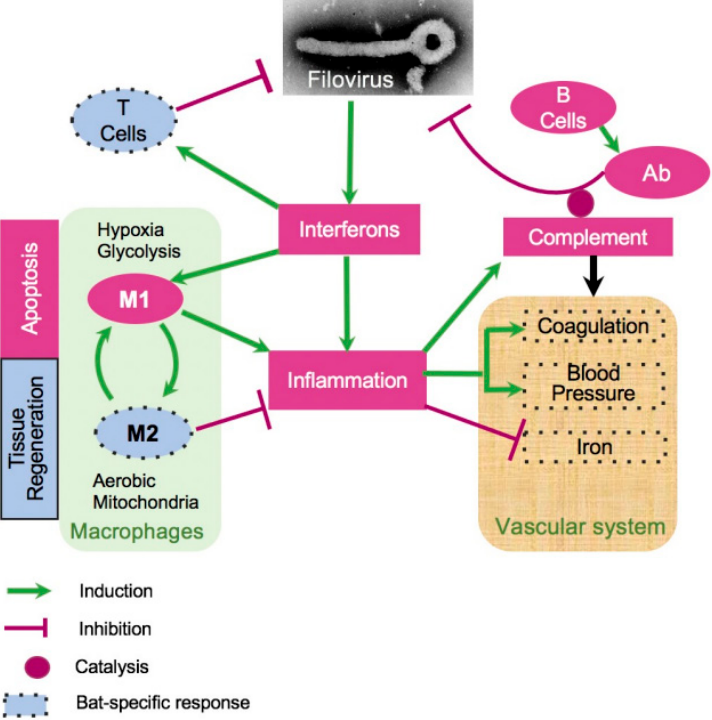
Figure 5. A model of bat response to filovirus infections. Interferon stimulated genes (ISG, Figures 4, S2 and S3) cause inflammation, which triggers the acute phase response (APR, Table 1, Figure 4), leading to a cascade of reactions affecting regulation of HAMP (iron, Figures 4 and S6), coagulation (Figures 4, S7 and S8), blood pressure (Figures 4 and S7), and stimulating M1 macrophages (Figures 4, S5, S10 and S11). The pro-inflammatory M1 macrophages phagocytose infected cells and promote apoptosis. Over the course of infection, M1 macrophages are converted to anti-inflammatory M2 macrophages. This process is accompanied by activation of fatty acid oxidation and mitochondrial activity, which are the hallmarks of the M2 macrophage responses (Figures 4, S10 and S11). On the other hand, activation of the complement system is incomplete, potentially leading to a reduced antibody activity (Figures 4 and S5B). Furthermore, filovirus infections were accompanied by down- regulation of blood pressure (Figures 4 and S7) and the coagulation system (Figures 4 and S9). The infections are also accompanied by shift in genes regulating iron homeostasis (Figures 4 and S7– S11), which are generally consistent with a greater activation of the M2 macrophage response in case of EBOV infections. The infections resulted in activation of CD8+ T cell response (Figure S5C), presumably contributing to clearance of the infections. The dotted boundaries indicate at pathways which responded to filovirus infections in bats differently from human.